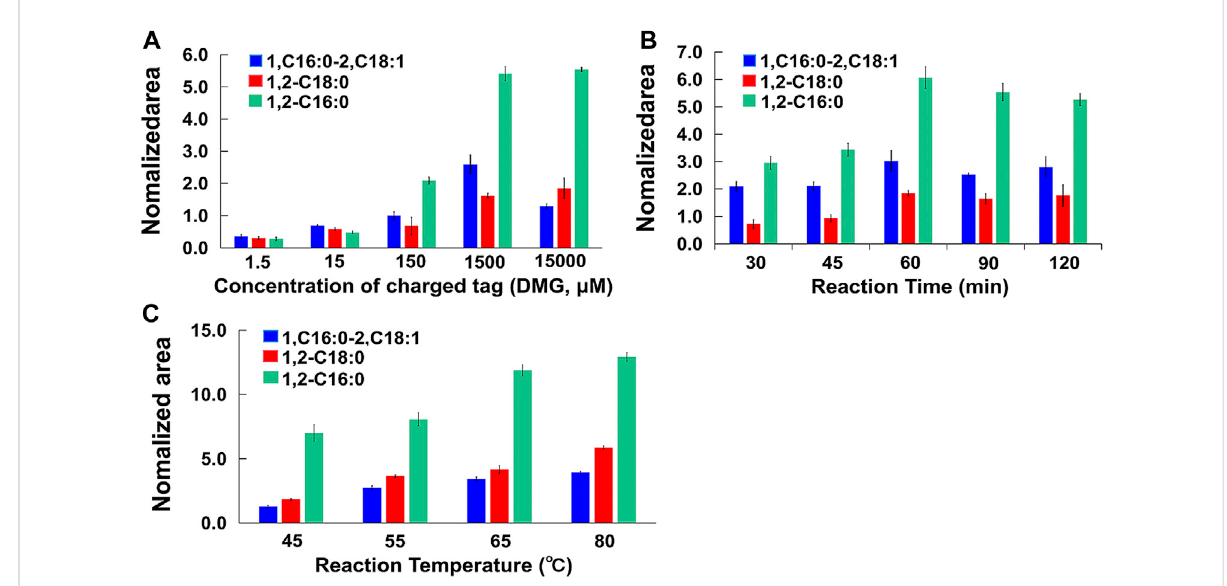
FIGURE 4 (A) Nomalizedarea oflabeled DAGs standers underdifferentconcentrationofcharged tag; (B) Nomalized areaoflabeledDAGs standers within different reaction time; (C) Nomalized area of labeled DAGs standers under different